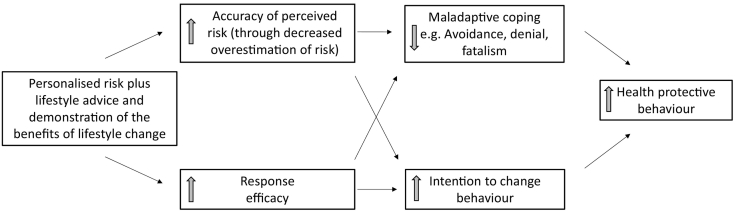
Proposed theoretical mechanism for intervention.